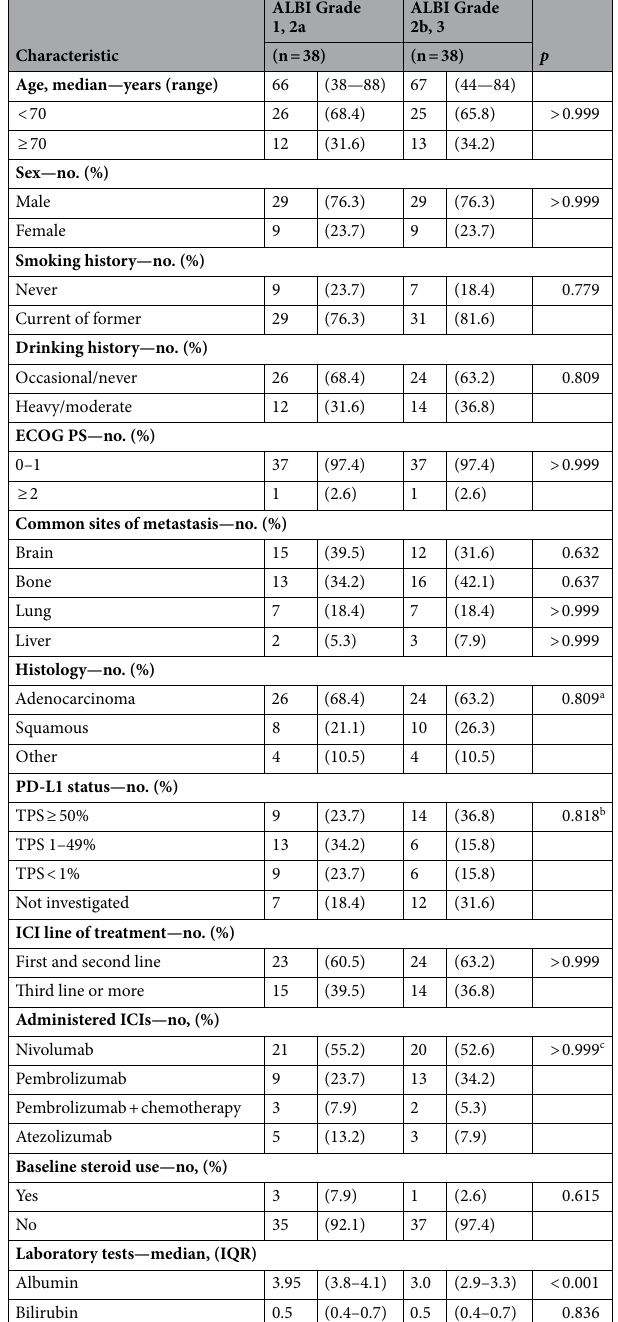
Table 5. Association between ALBI Grade and clinical variables in the propensity score-matched group. ALBI grade albumin–bilirubin grade, ECOG PS eastern cooperative oncology group performance status, PD-L1 programmed cell death ligand-1, ICI immune-checkpoint inhibitor, TPS tumor proportion score, IQR interquartile range. a Adenocarcinoma versus all others, b PD-L1 TPS ≥ 1% versus all others, c Administered of immune checkpoint inhibitors, Nivolumab versus all